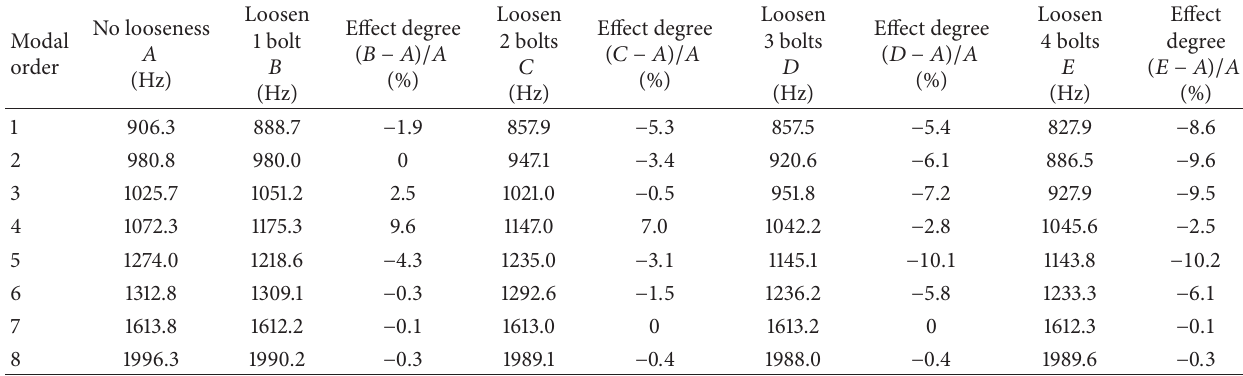
Table 7: Natural frequencies of TCS under BLB with different looseness numbers.